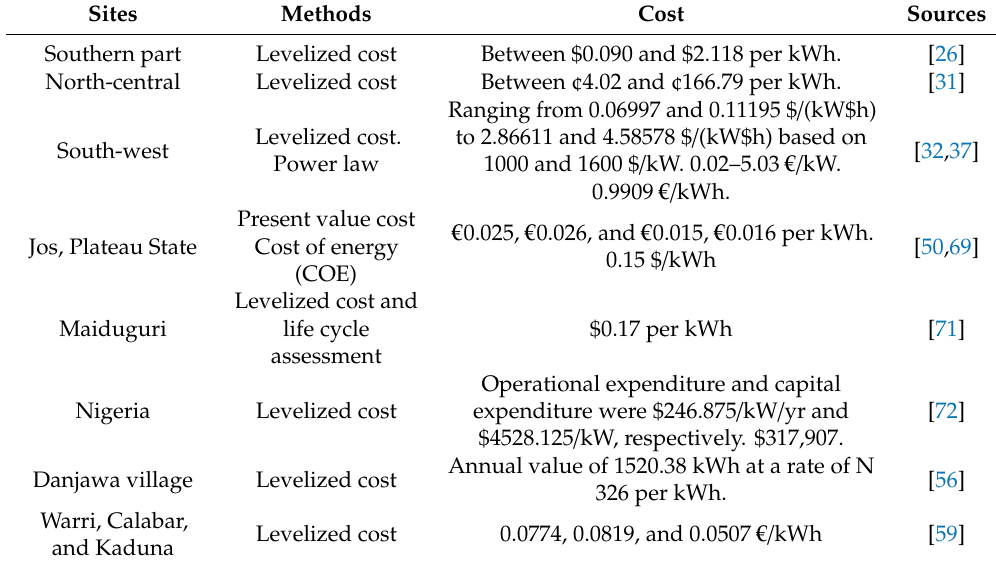
Table 2. Summary of studies on economic analysis of wind